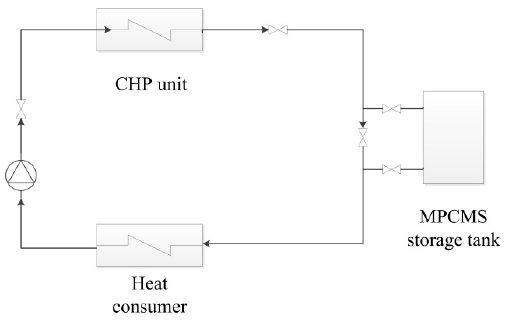
Figure 6. Schematic of MPCMS storage system.